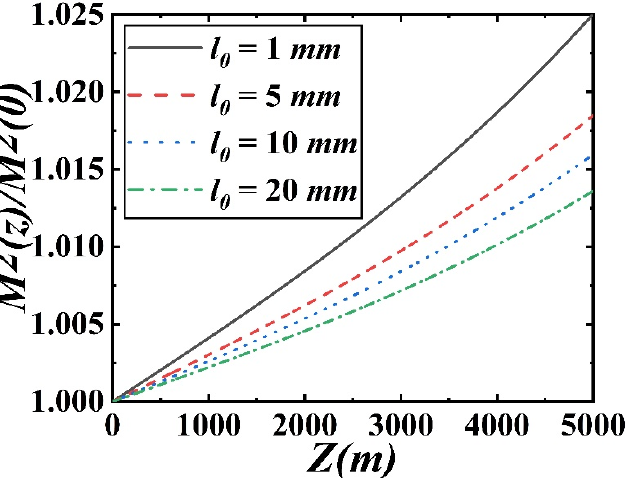
. The results of Figure 5 indicate that the rel ‐ Figure 4. Dimensionless quantity     2 2 0 M z M of a partially coherent Airy beam in non ‐ Kol ‐ Figure 4. Dimensionless quantity M 2 ( z ) / M 2 ( 0 ) of a partially coherent Airy beam in non-Kolmogorov ative beam quality decreases by decreasing the generalized structure constants. turbulence versus propagation distance for different l 0 . l . mogorov turbulence versus propagation distance for different 0